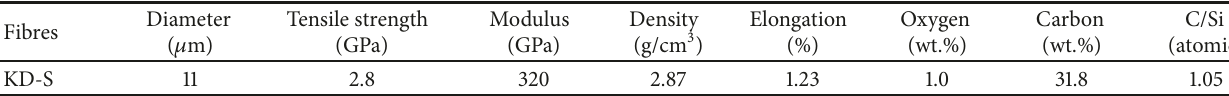
Table 1: The typical properties of KD-S fibres after